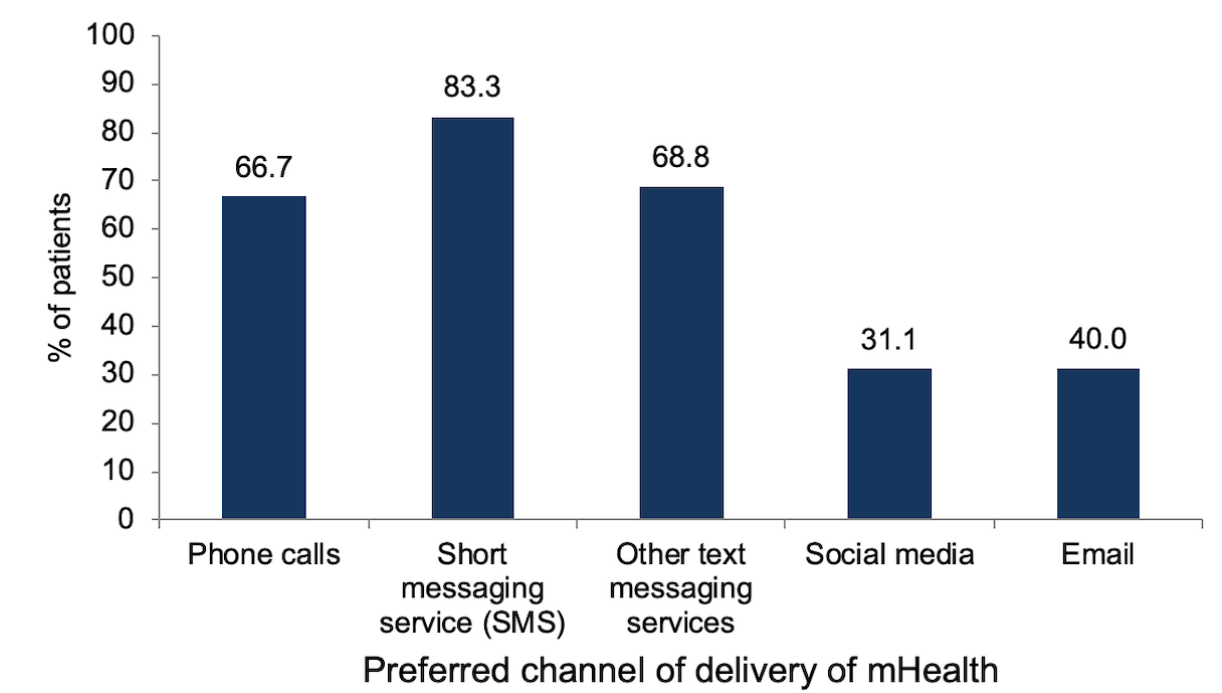
Figure 3. Preferred channel of delivery for mobile health intervention. mHealth: mobile